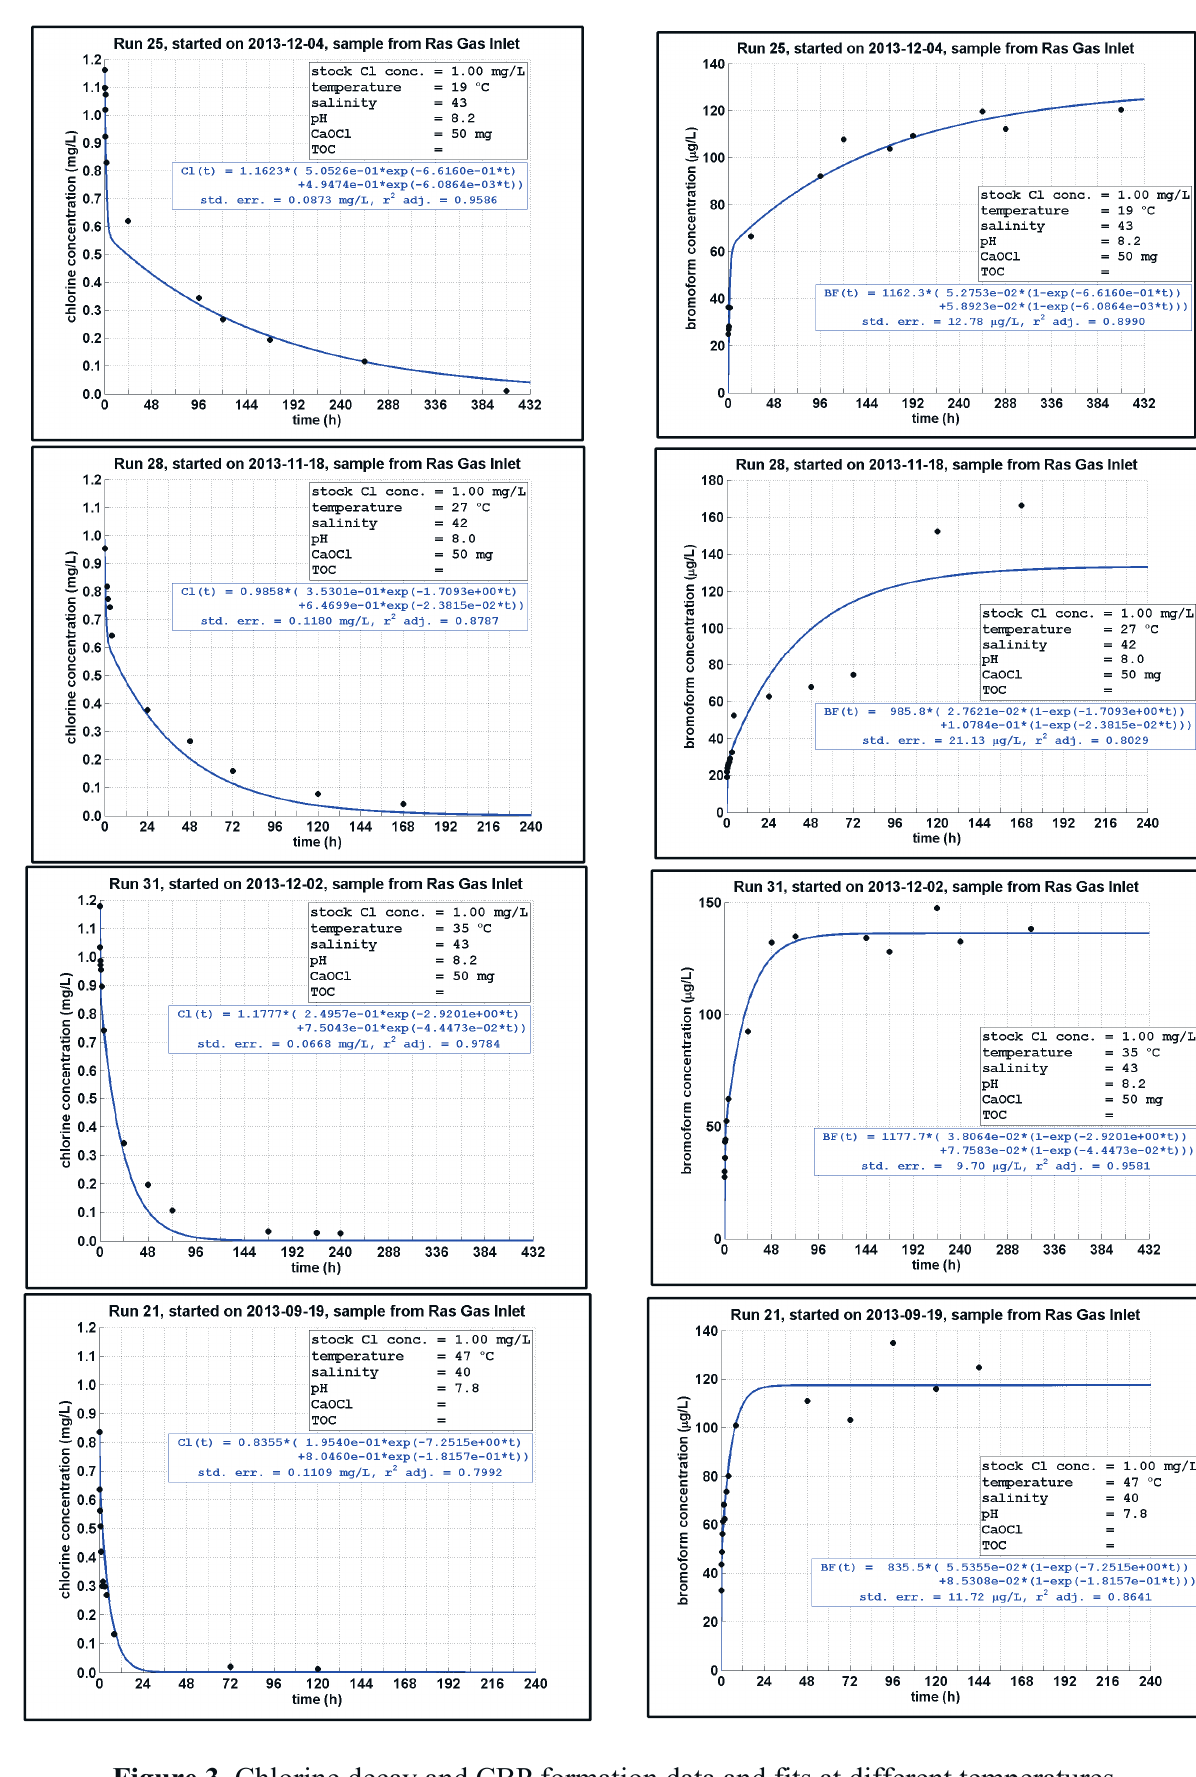
Figure 3. Chlorine decay and CBP formation data and fits at different